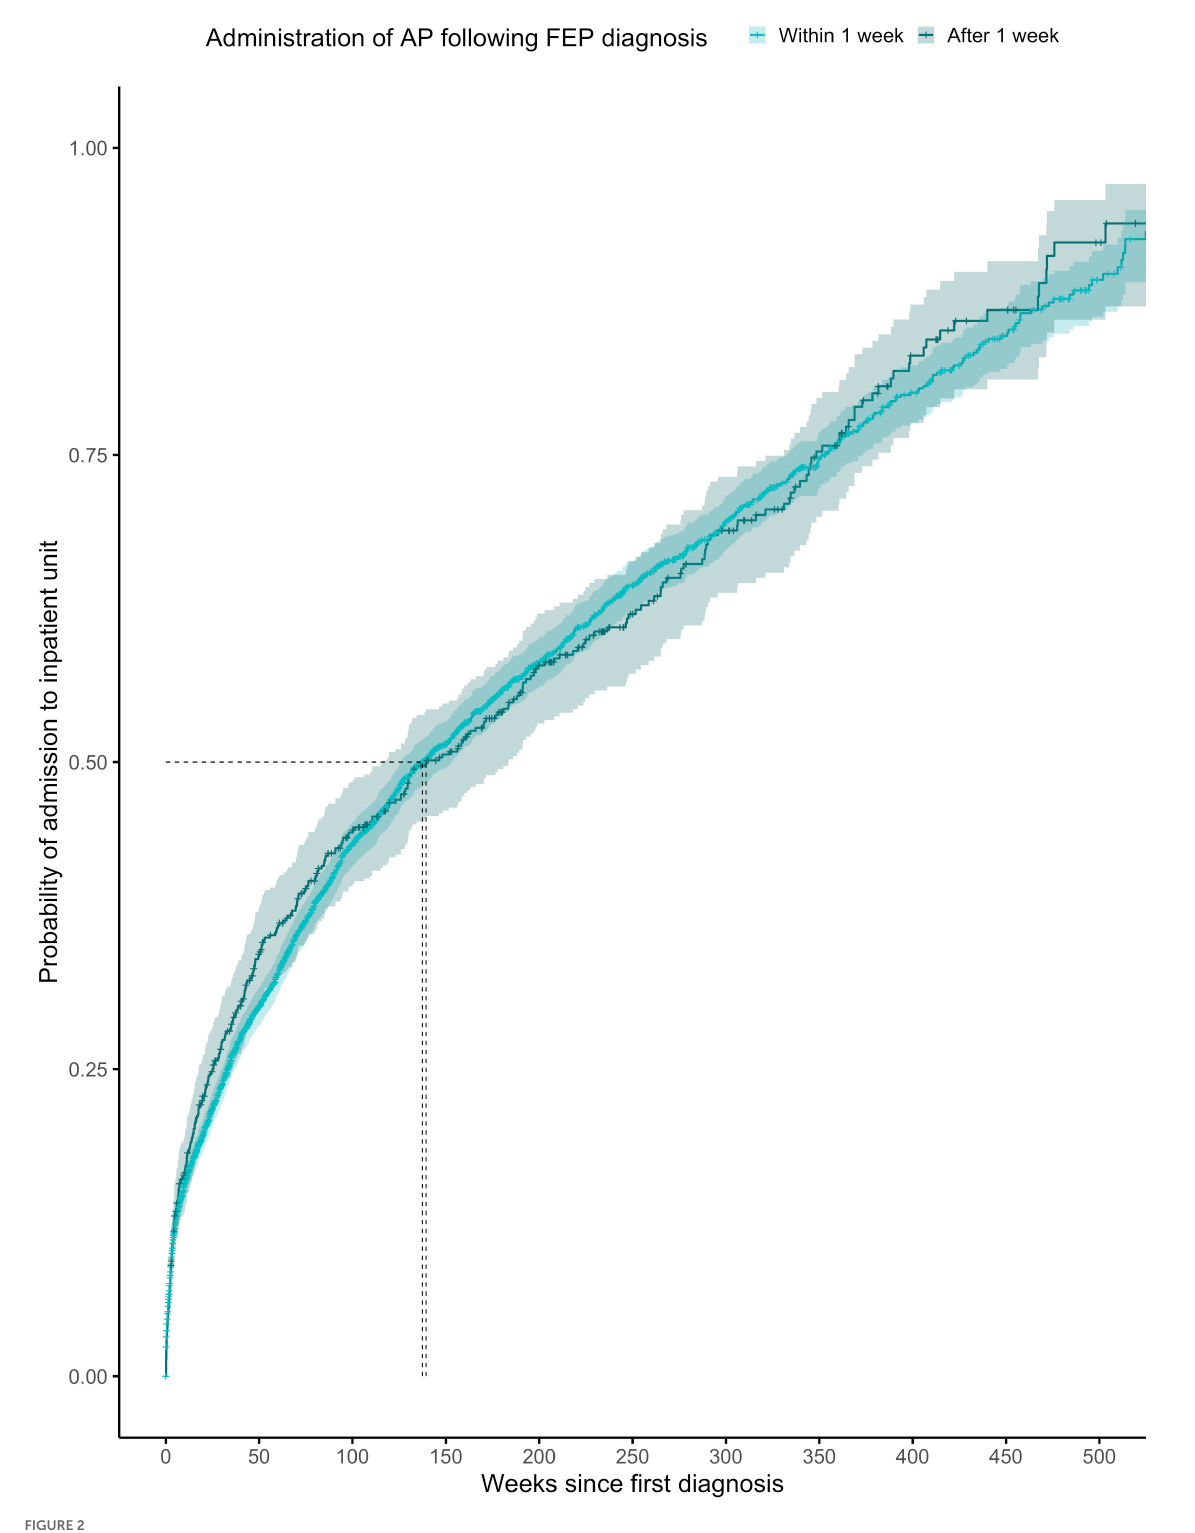
FIGURE2 Kaplan-Meier survival curve showing cumulative probability of any psychiatric admission over time (weeks) after FEP diagnosis for patients given antipsychotics within ≤ 1 week or > 1 week after diagnosis. Greenwood 95% confidence intervals are displayed for each curve. The dashed lines indicate the median time to admission in each